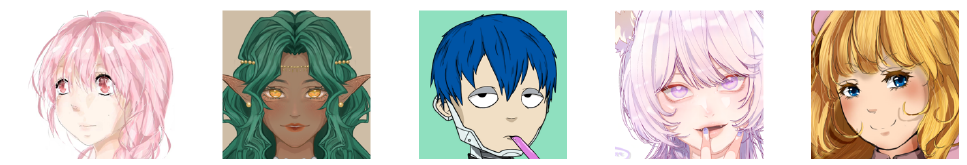
Figure 16. Example images from the anime face dataset (from Seeprettyface and Pixiv). HR is 512 × 512, LR are 64 × 64, 128 × 128, 256 × 256. The images are adopted from [37,38].